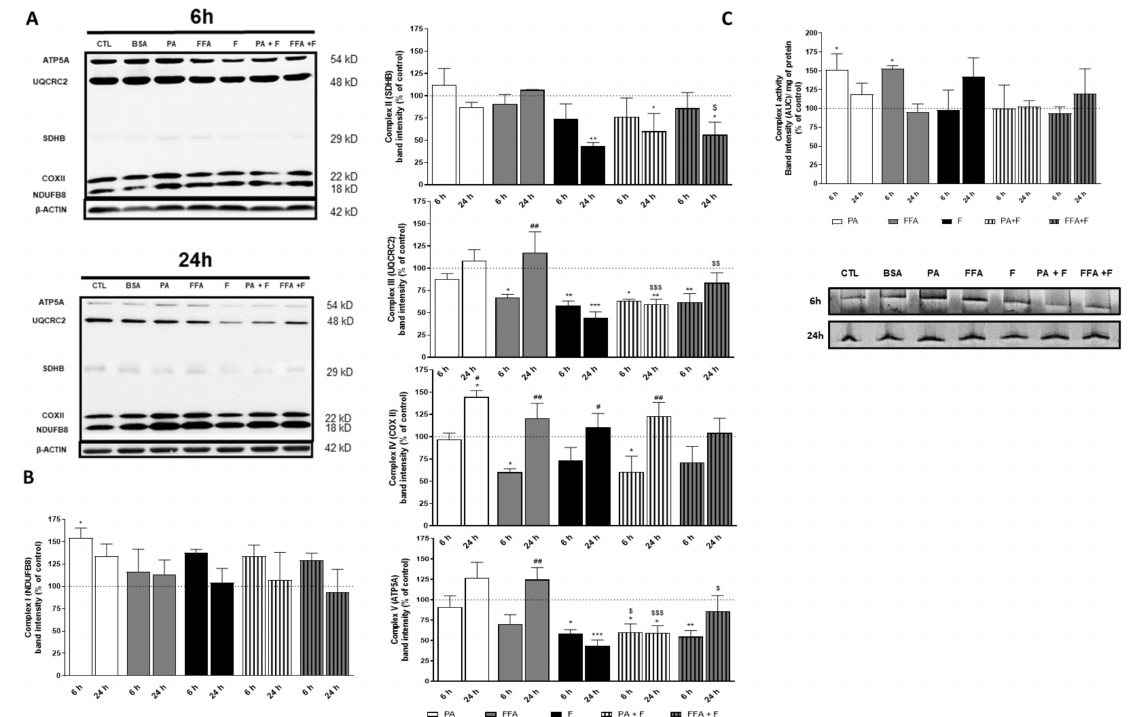
Figure 4. Effect of supra-physiological concentrations of FA on mitochondrial OXPHOS protein levels. ( A ) Typical Western blot result of whole cell homogenates showing the protein level of NDUFB8 (complex I), SDHB (complex II), UQCRC2 (complex III), COXII (complex IV), ATP5A (complex V) subunits, and β -actin (cytosolic marker) in cells treated with palmitic acid (PA, 0.5 mM) or a mix of free fatty acids (FFA, 0.25 mM) in the presence or absence of fructose (F, 10 mM) for 6 and 24 h. This blot was inverted and contrast-optimized for visualization purposes. Quantification of the bands was performed using the original blots. ( B ) Quantification of OXPHOS proteins levels in multiple experiments normalized to β -actin levels and for the control group (100% marked by a dotted line). ( C ) Typical BN-PAGE in-gel activity result of mitochondrial-enriched fraction homogenates depicting the protein activity of mitochondrial complex I (NADH:ubiquinone oxidoreductase) in cells treated with palmitic acid (PA; 0.5 mM) or a mix of free fatty acids (FFA; 0.25 mM) in the presence or absence of fructose (F; 10 mM) for 6 and 24h. This image was inverted and contrast-optimized for visualization purposes. Quantification of the bands was performed using the original images. Data are the mean ± SEM of four independent experiments, and the results normalized on the control condition (CTL = 100%, marked by a dotted line). Significance was accepted with * p < 0.05, ** p <0.01, *** p < 0.0005 for comparisons between treatment vs. CTL (BSA 0.01 g/mL) and # p < 0.05, ## p < 0.01 for comparisons during time in the same group (24 and 6 h vs. 1 h). Significance for additional fructose effect as accepted with $ p < 0.05, $$ p < 0.01, $$$ p <